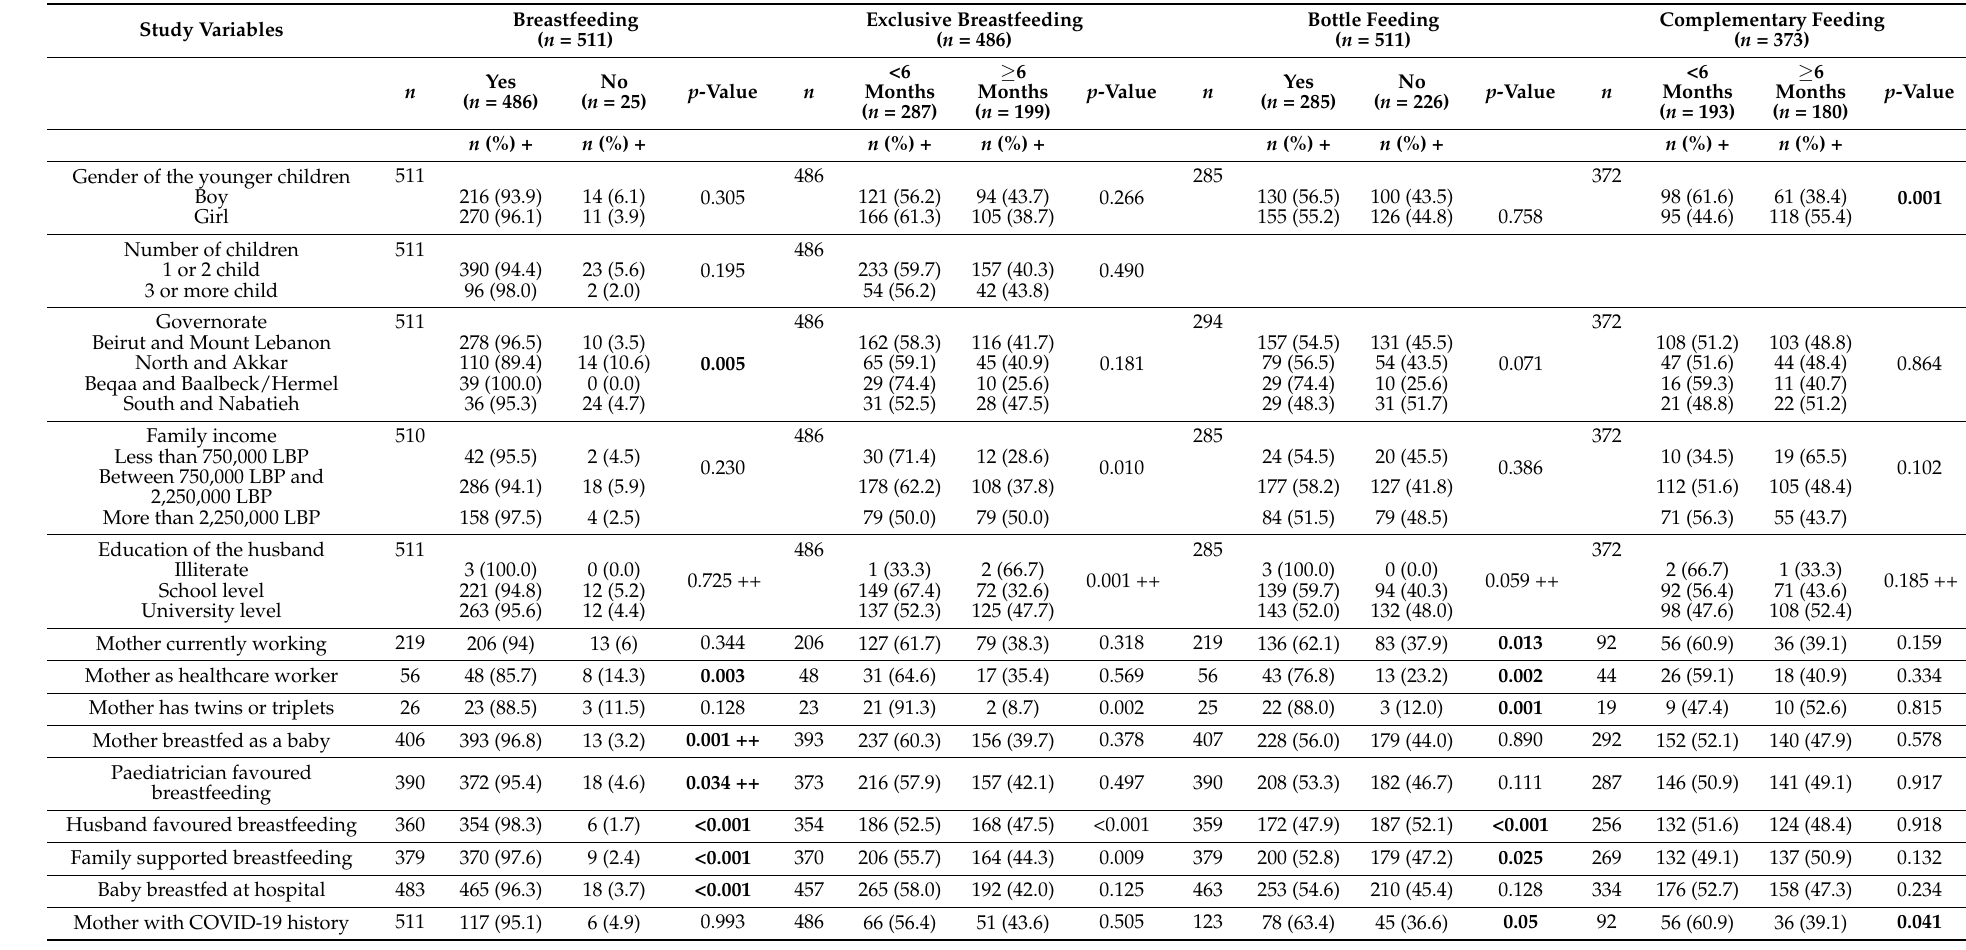
Table 4. Factors associated with breastfeeding, bottle feeding, and complementary